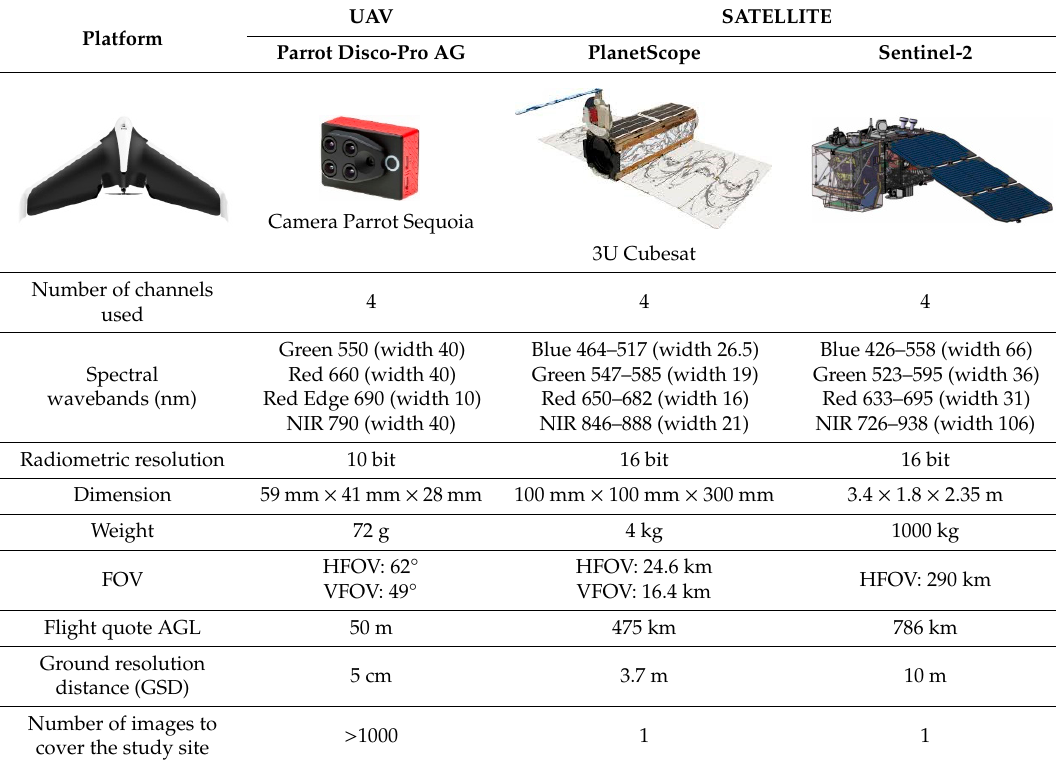
Table 1. Characteristics of the multispectral camera and of the satellites whose images were used in this